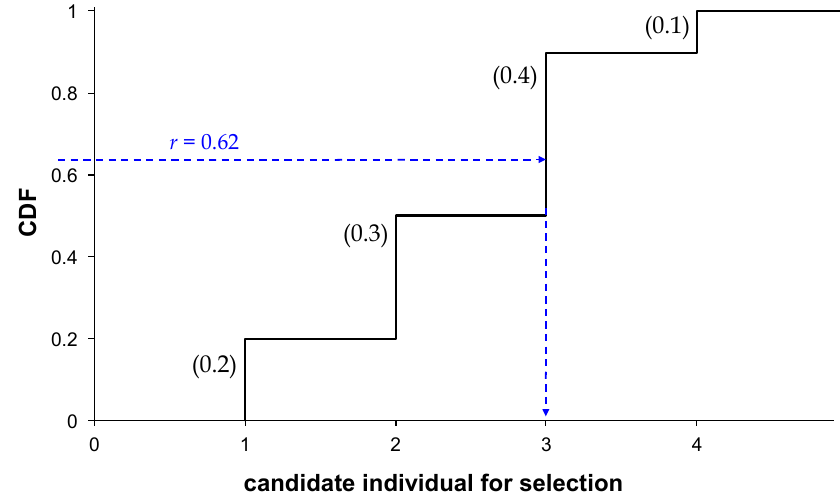
Figure 2. Random selection from Cumulative Distribution Function (CDF).